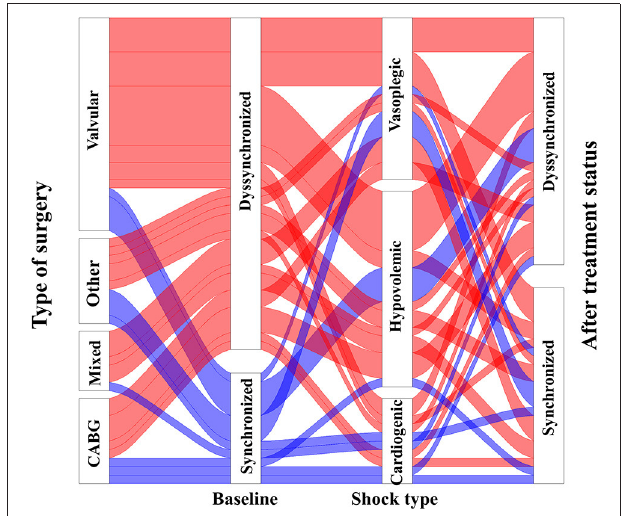
FIGURE 1 | Representation of baseline ventricular dyssynchrony (t-IVT), and its evolution according to baseline and hemodynamic treatment.